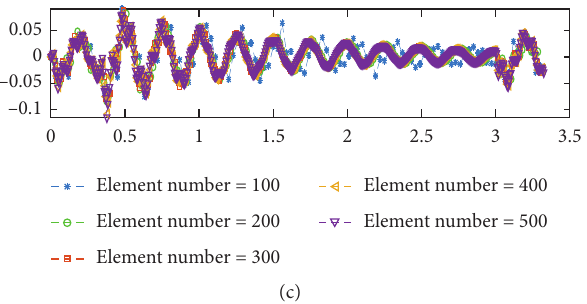
Figure 14: Bridge acceleration history x time (s) and y acceleration (m 2 /s)). (a) At L /3. (b) At L /2. (c) At 2 L /3.